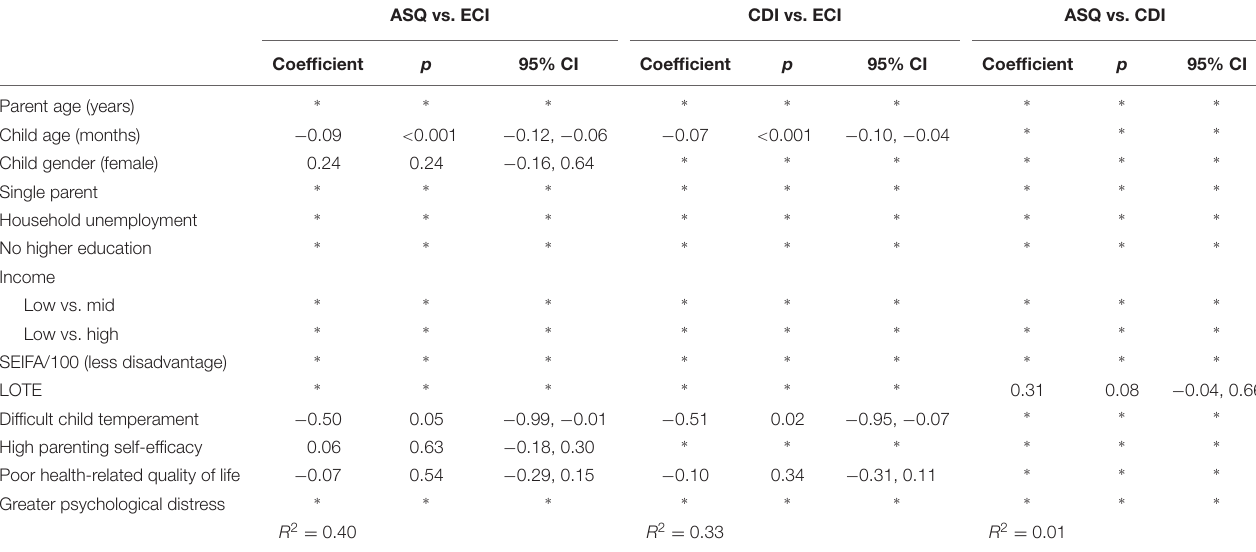
TABLE 6 | Adjusted analysis for the Early Home Learning Study difference scores and socio-demographic factors (child language